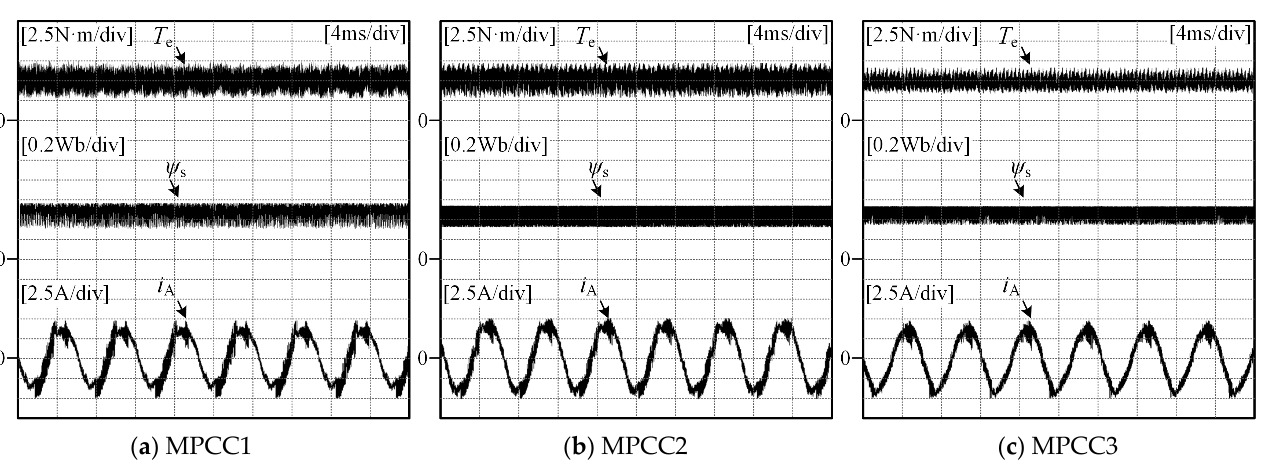
( b ) MPCC3 Figure 8. Neutral point potential balance capability. 4.2.2. Control Performance under Steady State For different load torque T L and motor speed n r operating conditions (case 1: T L = 5 N·m, n r = 500 r/min, v c1 = 140 V, v c2 = 180 V; case 2: T L =10 N·m, n r = 500 r/min, v c1 = 140 V, v c2 = 180 V), the experimental results of the stator current i A , electromagnetic torque T e (The experimental result of torque is estimated by the stator current, flux linkage and rotator position), amplitude of stator flux | ψ s | and neutral point potential v o are shown in Figures 9 and 10. It can be seen that when the amplitude of the neutral point potential is large, the current and torque fluctuation of MPCC3 is lower than that of MPCC1 and MPCC2. As for MPCC3, the change of the amplitude and the phase angle of basic vectors are fully considered and the actual optimal vector is selected. The torque fluctuation rate D T and flux fluctuation rate D ψ are used as torque perfor- mance and flux performance indicators and are defined as follows: